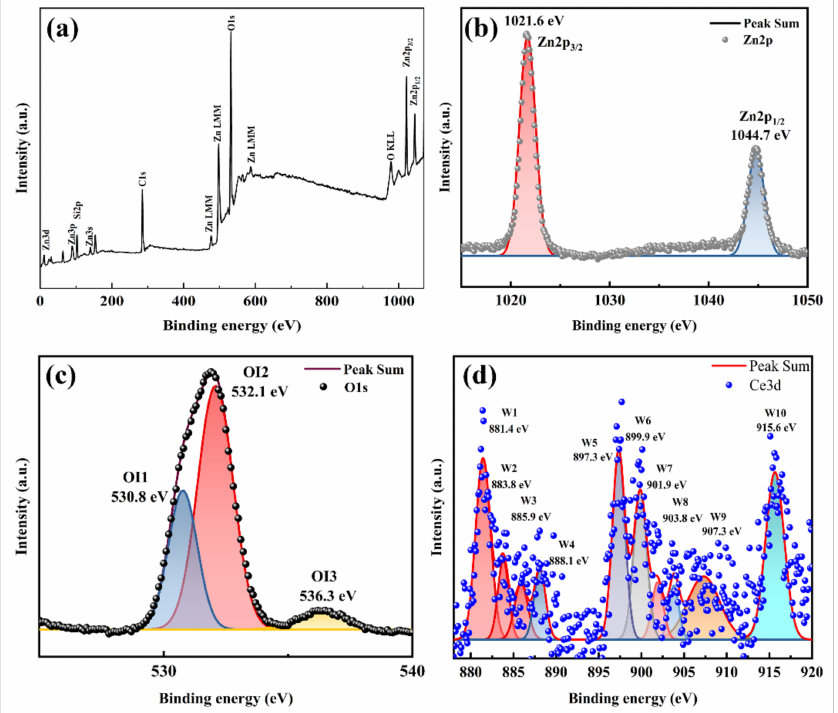
Figure 2. XPS analysis of the n-Ce:ZnO NL/p-BDD heterojunction. ( a ) Full-scan XPS of the n-Ce:ZnO NL/p-BDD heterojunction. High-resolution XPS spectra of ( b ) Zn2p, ( c ) O1s, and ( d )